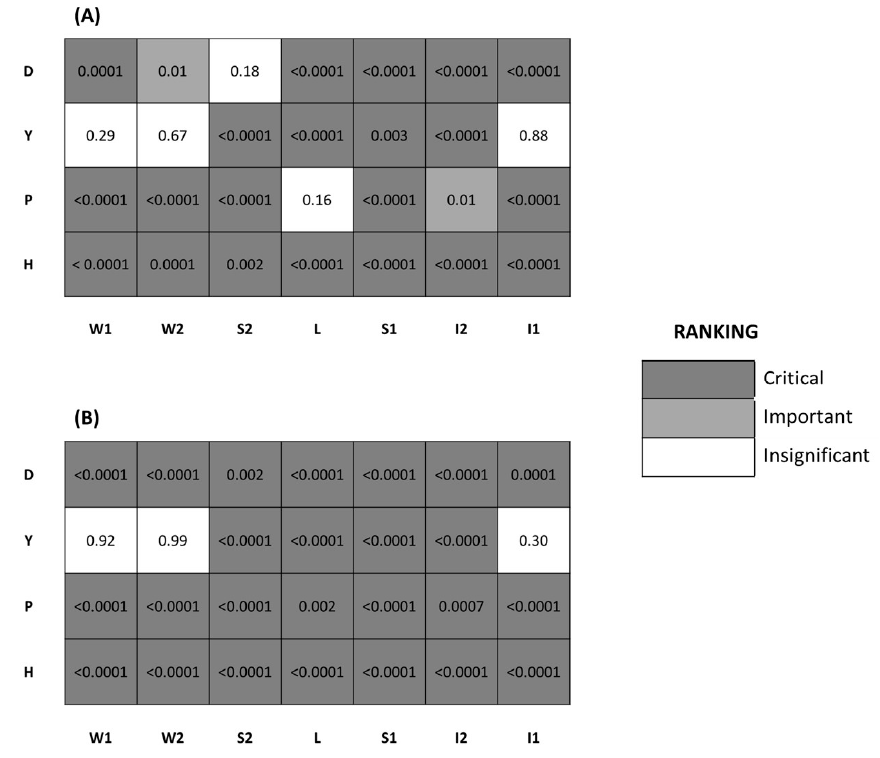
Figure 3. Heatmaps from the Kolmogorov–Smirnov tests for each factor relative to each clone in two conditions: present ( panel A ) and climate change ( panel B ). The p -values ( α ) from the regionalized sensitivity analysis are reported and the ranking criteria labelled with different colors (critical: dark grey; important: light grey; and insignificant: white).